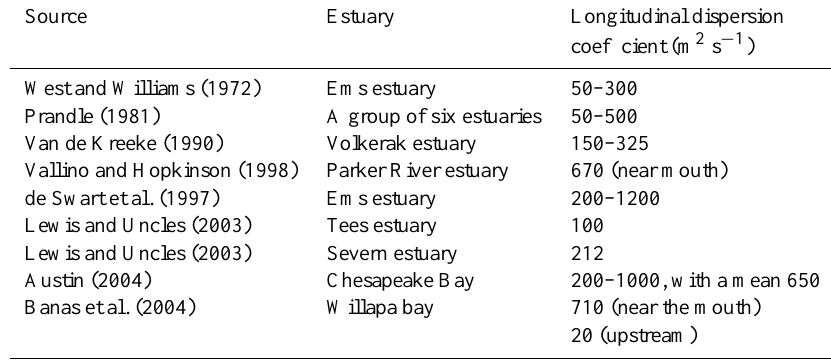
Table 1. Summary of the estimated longitudinal dispersion coefficient for different estuaries.